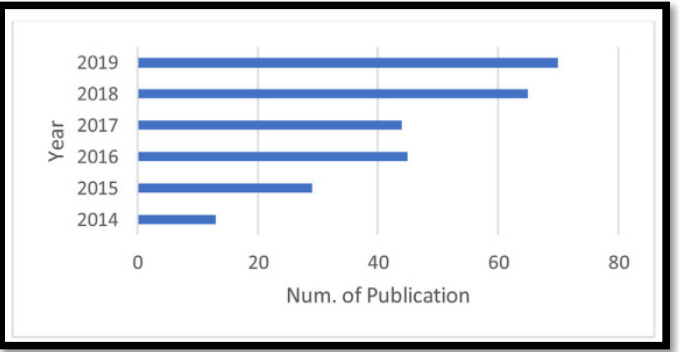
Figure 10. Research articles published about the advancements of MQL from 2014 to 2019 [83].